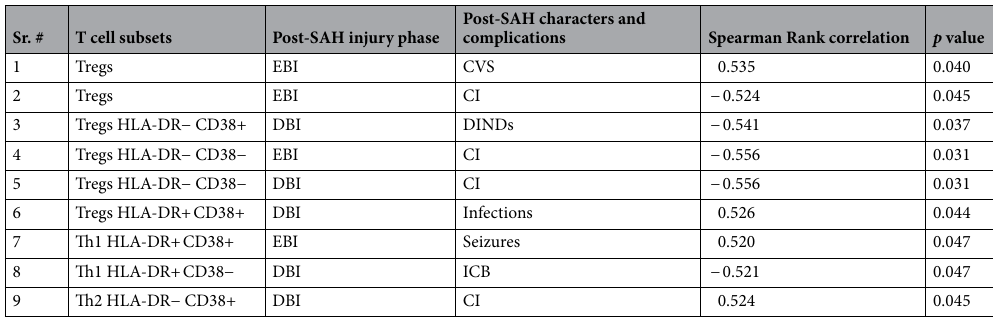
Table 2. Correlations of different T helper cell subsets and their activation states with different post-SAH complications.